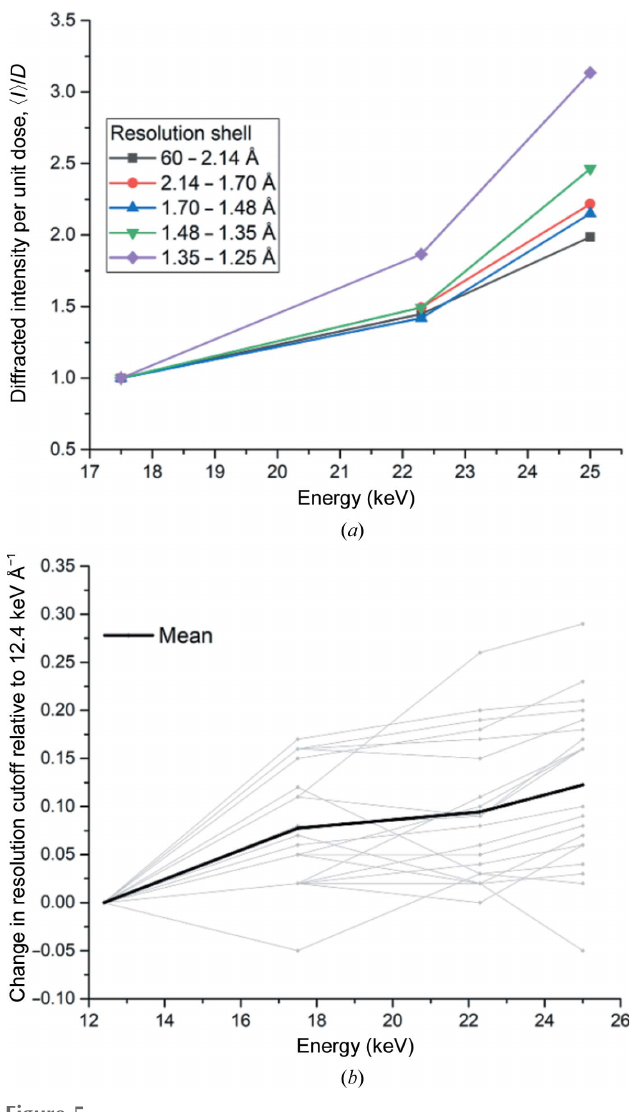
Figure 5 ( a ) Resolution dependence of the diffracted intensity per unit absorbed dose, h I i / D . To allow direct comparison of different resolution shells, h I i / D in each resolution shell is normalized to the value at 17.5 keV. The mean diffracted intensity, h I i , is scaled to the illuminated crystal volume. ( b ) Energy-dependent change in resolution cutoff as ascertained using a criterion of CC 1/2 > 0.33 for 20 crystals. The mean change in resolution is shown as a thick black